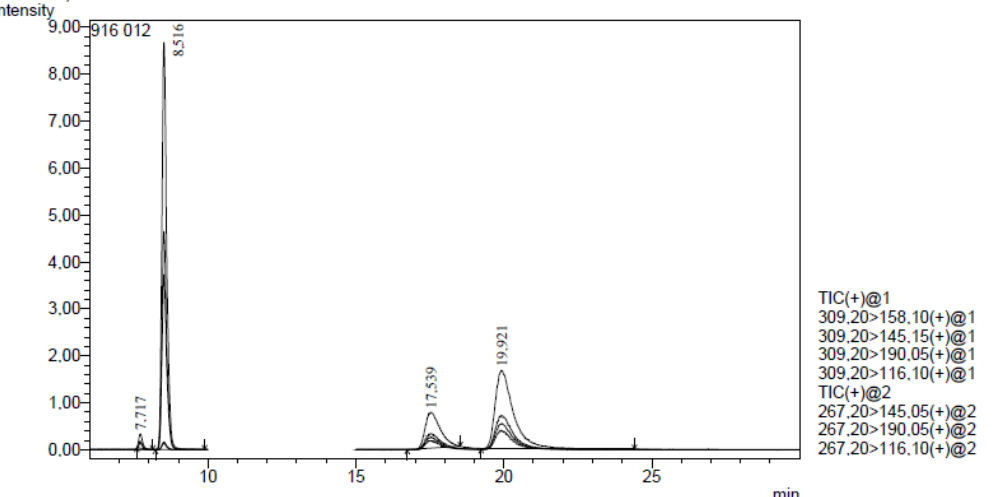
Figure 7. Chromatogram of ( R , S )-atenolol and its esters after 120 h of kinetic resolution of ( R , S )- atenolol with the use of Candida rugosa OF in two-phase reaction media containing [EMIM] [BF 4 ] and toluene: ( R )-enantiomer of atenolol acetate (t R = 7.717), ( S )-enantiomer of atenolol acetate (t R = 8.516), ( S )-atenolol (t R = 17.539), ( R )-atenolol (t R = 19.921). Chromatographic conditions: Lux Cellulose-2 (4.6 × 250 mm × 3 µm) column, mobile phase: acetonitrile/2-propanol/diethylamine (98/2/0.1 v/v/v), F = 1 mL/min, t = 30 °C.